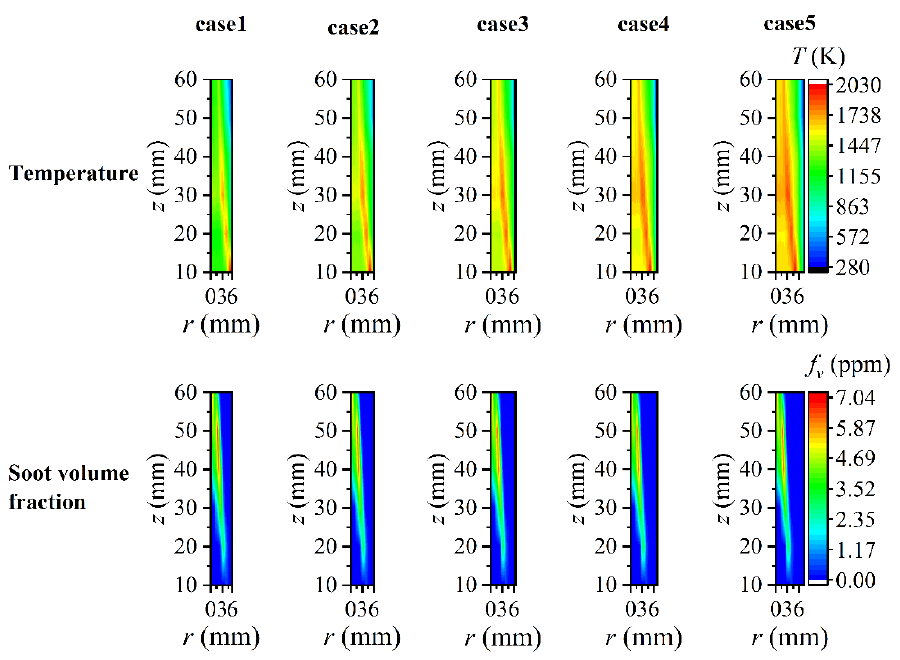
Figure 19. The exact flame temperature and soot volume fraction considering different reconstruction boundaries.